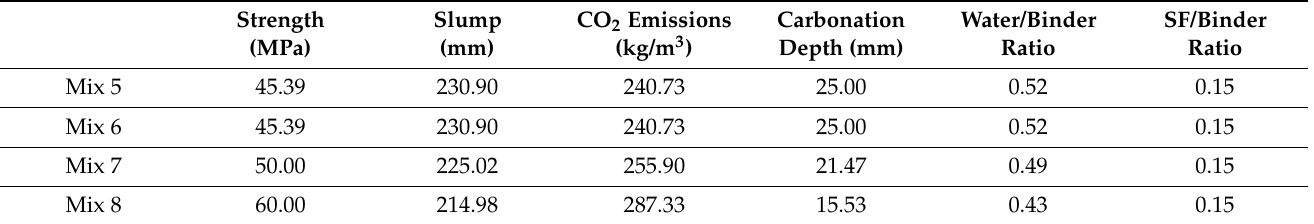
Table 9. Performance of optimal design mixtures for Case 2: low-CO 2 concrete with